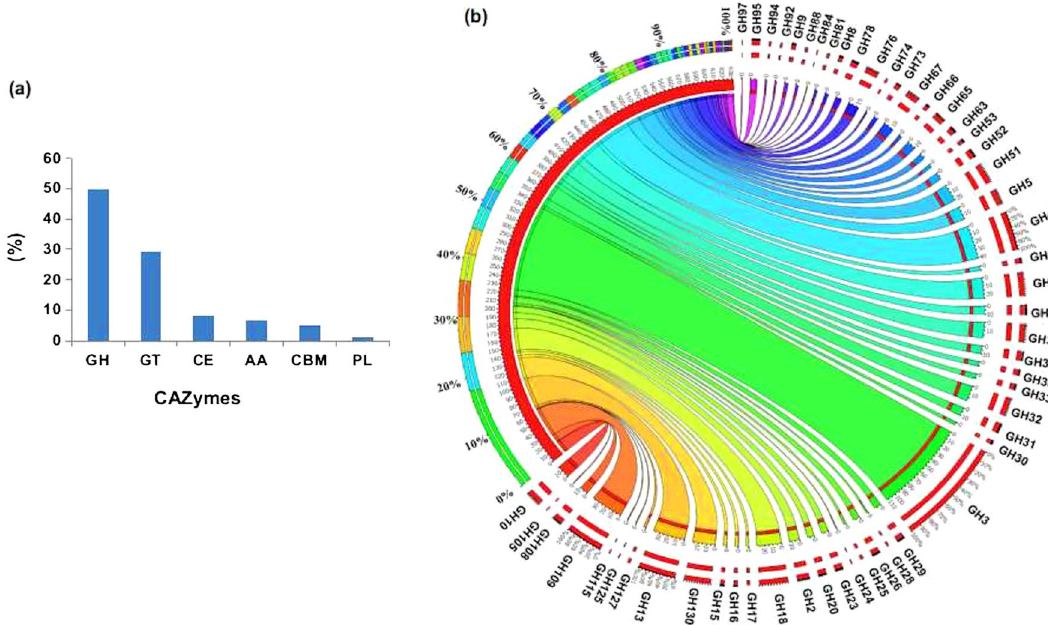
Figure 6. Distribution of lignocellulose depolymerizing CAZymes in RSV consortium. ( a ) Relative abundance of GHs, GTs, AAs, CBMs and PLs, and ( b ) Distribution of glycoside hydrolases (GH) as visualized by Circos software. The width of the bars from each GH family indicates its relative abundance in the RSV